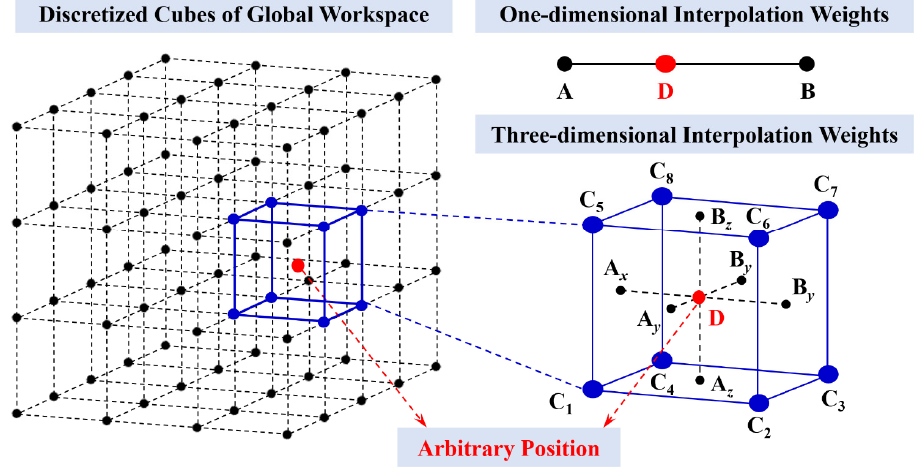
Figure 7. Discretized workspace and linear interpolation.